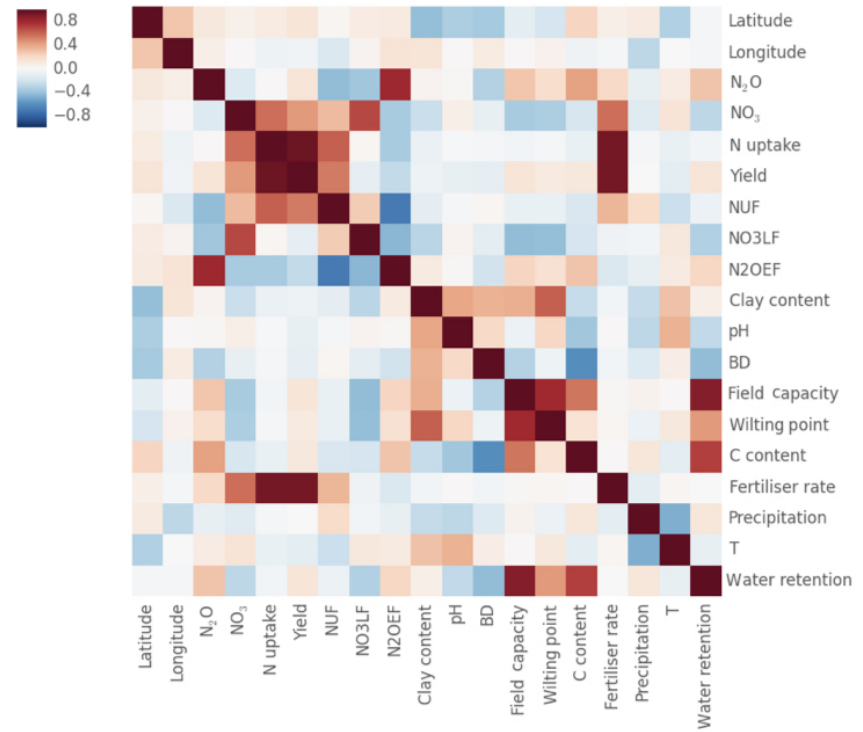
Figure 9. Heatmap of correlations between model inputs and outputs and estimated factors.